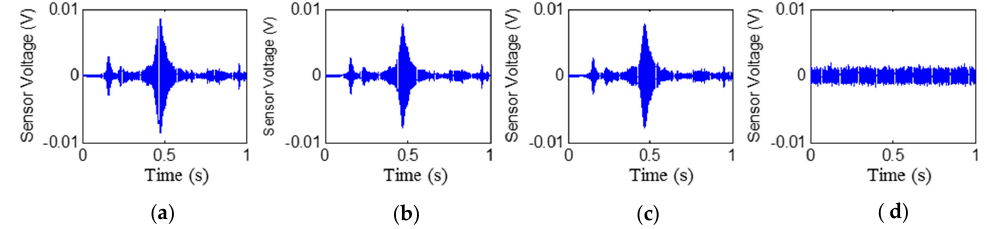
Figure 8. Signal received by PZT 6 (PZT5–PZT6 pair): Stage 0 to Stage 3 from left to the right. ( a ) Stage 0; ( b ) Stage 1; ( c ) Stage 2; ( d ) Stage